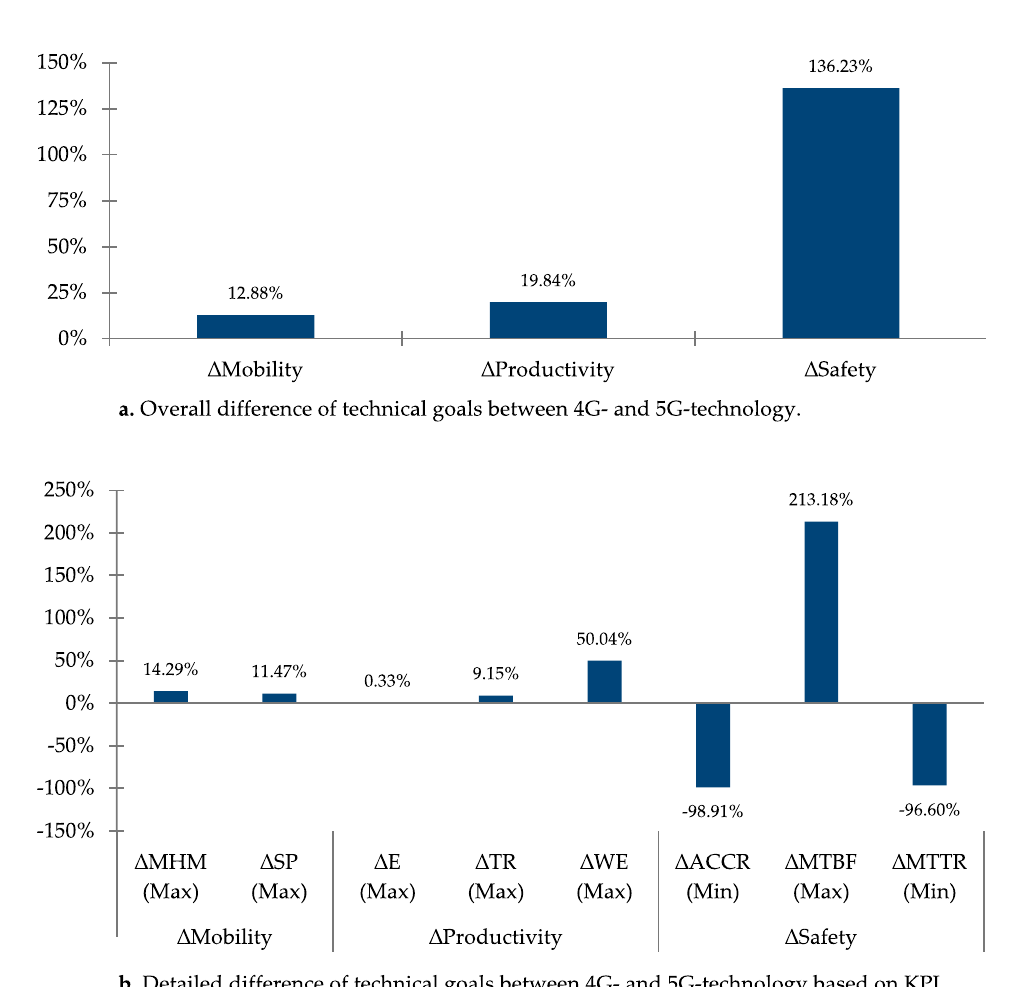
Figure 8. Influence on technical goals of 5G compared to 4G.